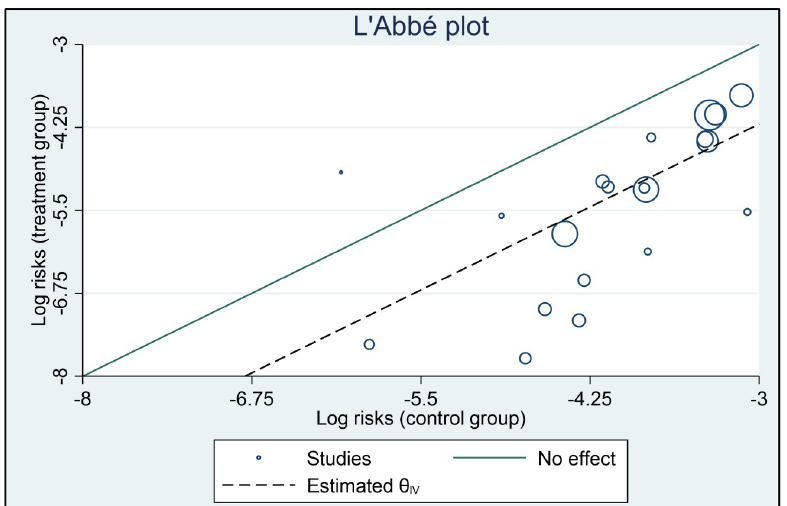
Fig 3. L’Abbe plot to explore heterogeneity.